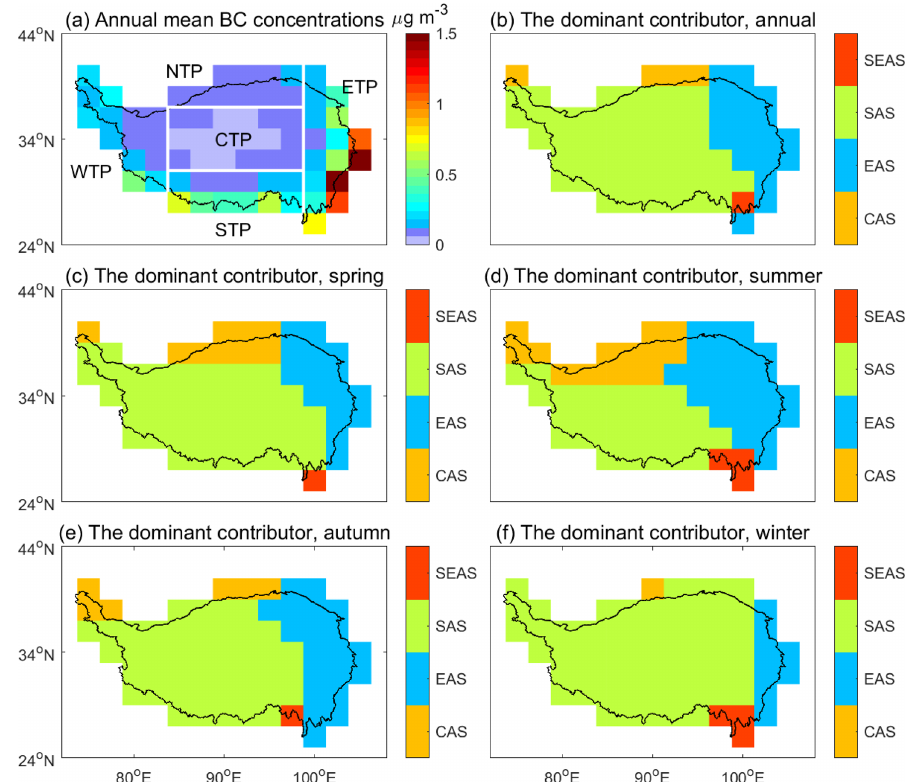
Figure 4. Surface BC over the TP and the dominant BC non-local source regions for the TP. (a) Annual mean BC concentrations over the TP. (b–f) The dominant BC non-local source regions (Fig. 1b) for each model grid in the TP for (b) the annual mean, (c) spring, (d) summer, (e) autumn, and (f) winter. The values are 20-year means (1995–2014) from the CTRL simulation. Non-local source regions in (b) – (f) include central Asia (CAS), East Asia (EAS), South Asia (SAS), and South East Asia (SEAS). The solid white lines in (a) separate the subregions of the TP defined in this study, i.e. western TP (WTP), northern TP (NTP), central TP (CTP), southern TP (STP), and eastern TP (ETP). The dark black line encloses the domain of the